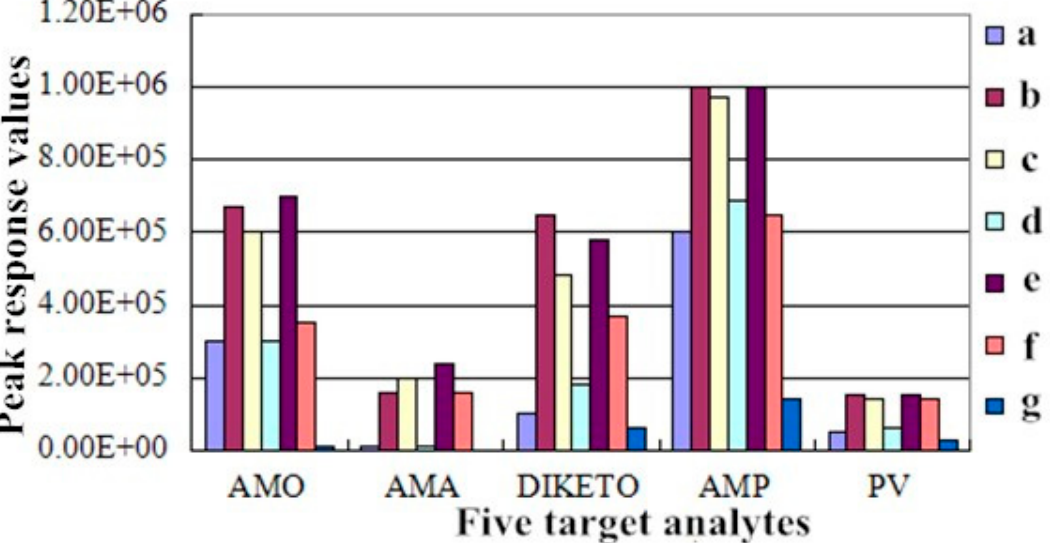
Figure 1. Effect of the HPLC mobile phase composition on the peak response values of AMO, AMA, DIKETO, AMP, and PV. Note: a–g represent the seven different mobile phase compositions reported in the article: ( a ) 0.1% formic acid-pure acetonitrile; ( b ) 0.15% formic acid-pure acetonitrile; ( c ) 0.2% formic acid-pure acetonitrile; ( d ) 0.1% formic acid and 0.1% formic acid-acetonitrile; ( e ) 0.15% formic acid and 0.1% formic acid-acetonitrile; ( f ) 0.15% formic acid and 0.15% formic acid-acetonitrile; and ( g